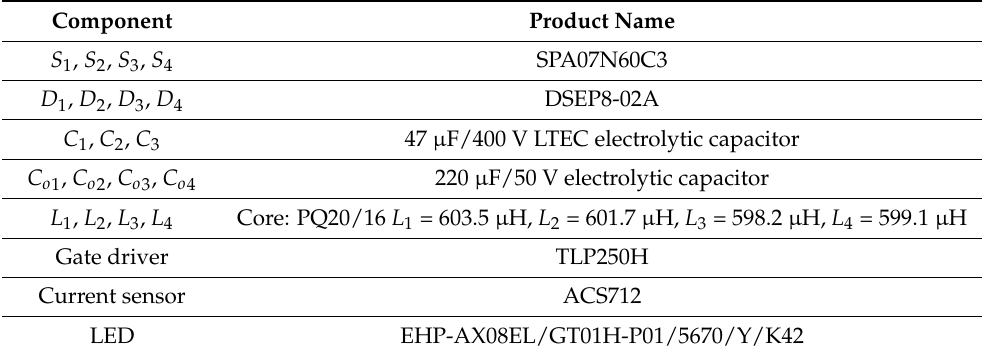
Table 3. Component